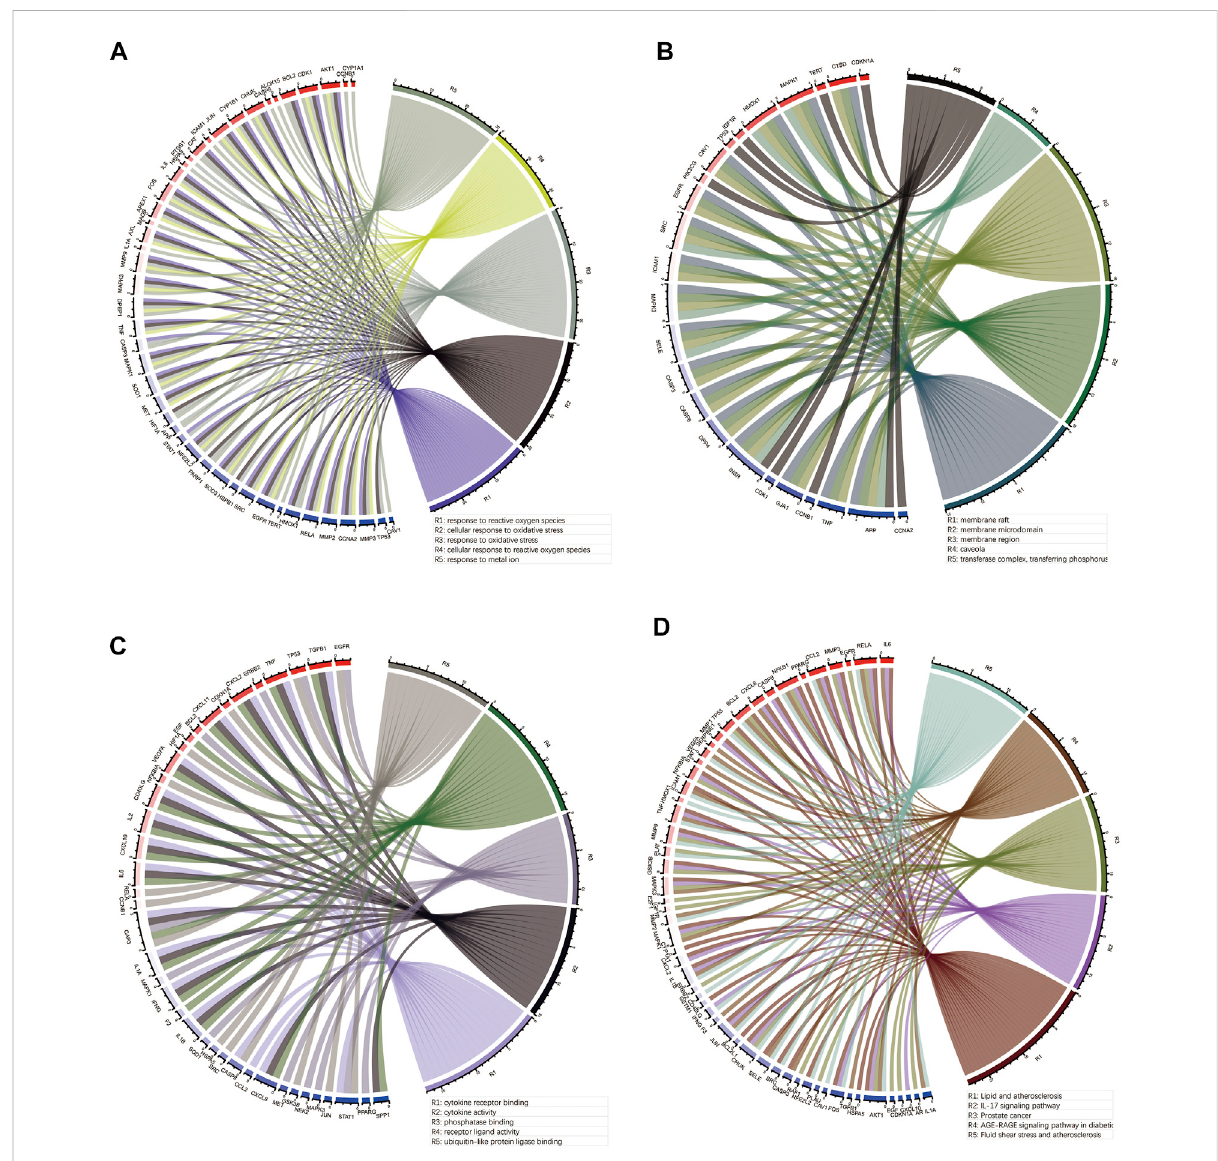
FIGURE 9 Outcomes of the top 5 bioinformatics analyses and the corresponding genes. (A – C) Outcomes of GO enrichment analysis for BP, CC and MF. (D) Outcomes ofKEGG enrichment analysis. GO: Gene ontology; KEGG: Kyoto Encyclopedia of Genesand Genomes; BP:biological processes;CC: cellular components; MF: molecular